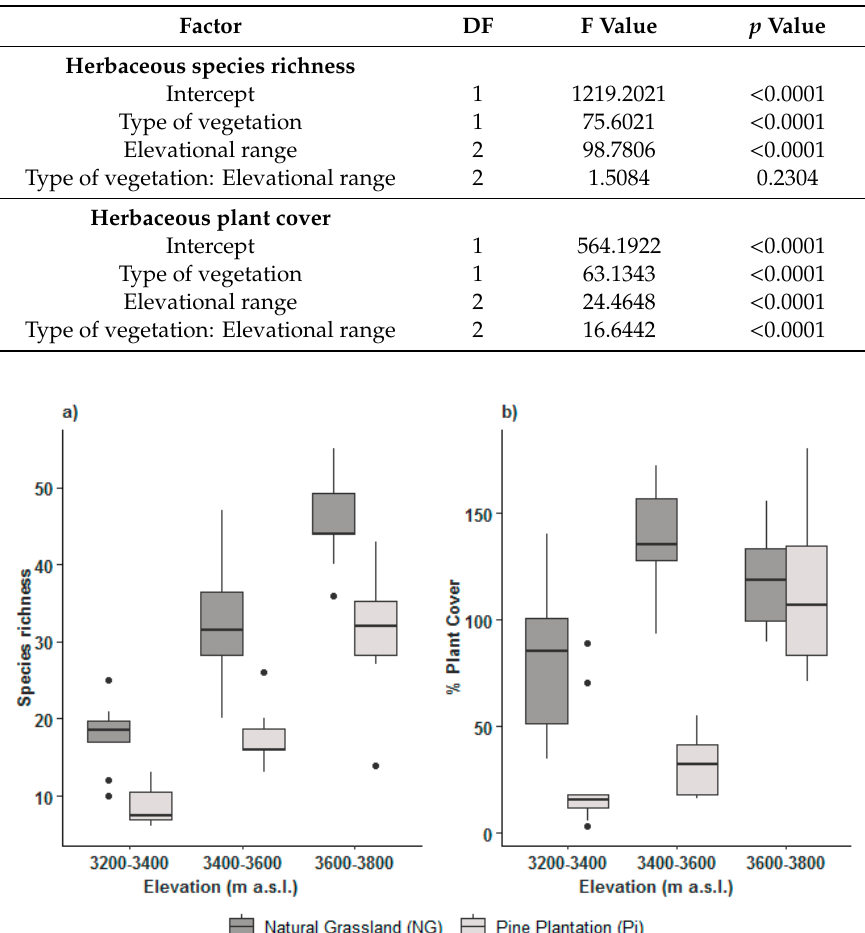
Figure 2. Box plots for the e ff ects of elevational range (3200–3400, 3400–3600, and 3600–3800 m a.s.l.) and vegetation (Pi, NG) on ( a ) herbaceous species richness and ( b ) percentage of herbaceous vegetation